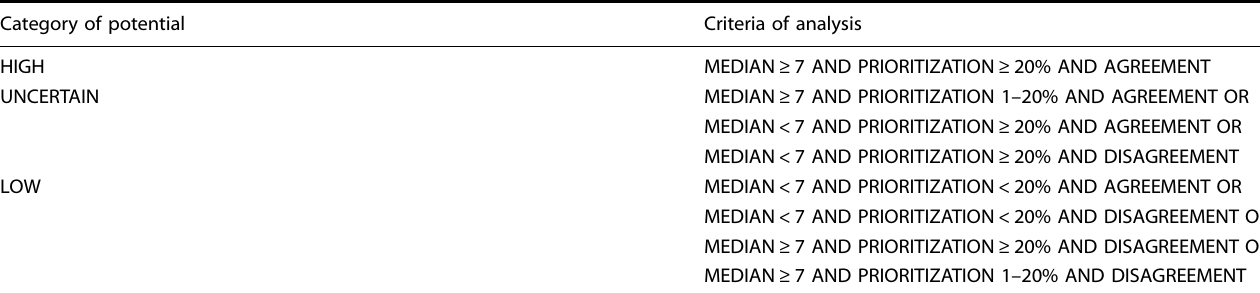
Table 1. Classifying recommendations and QIs into categories of high, uncertain and low